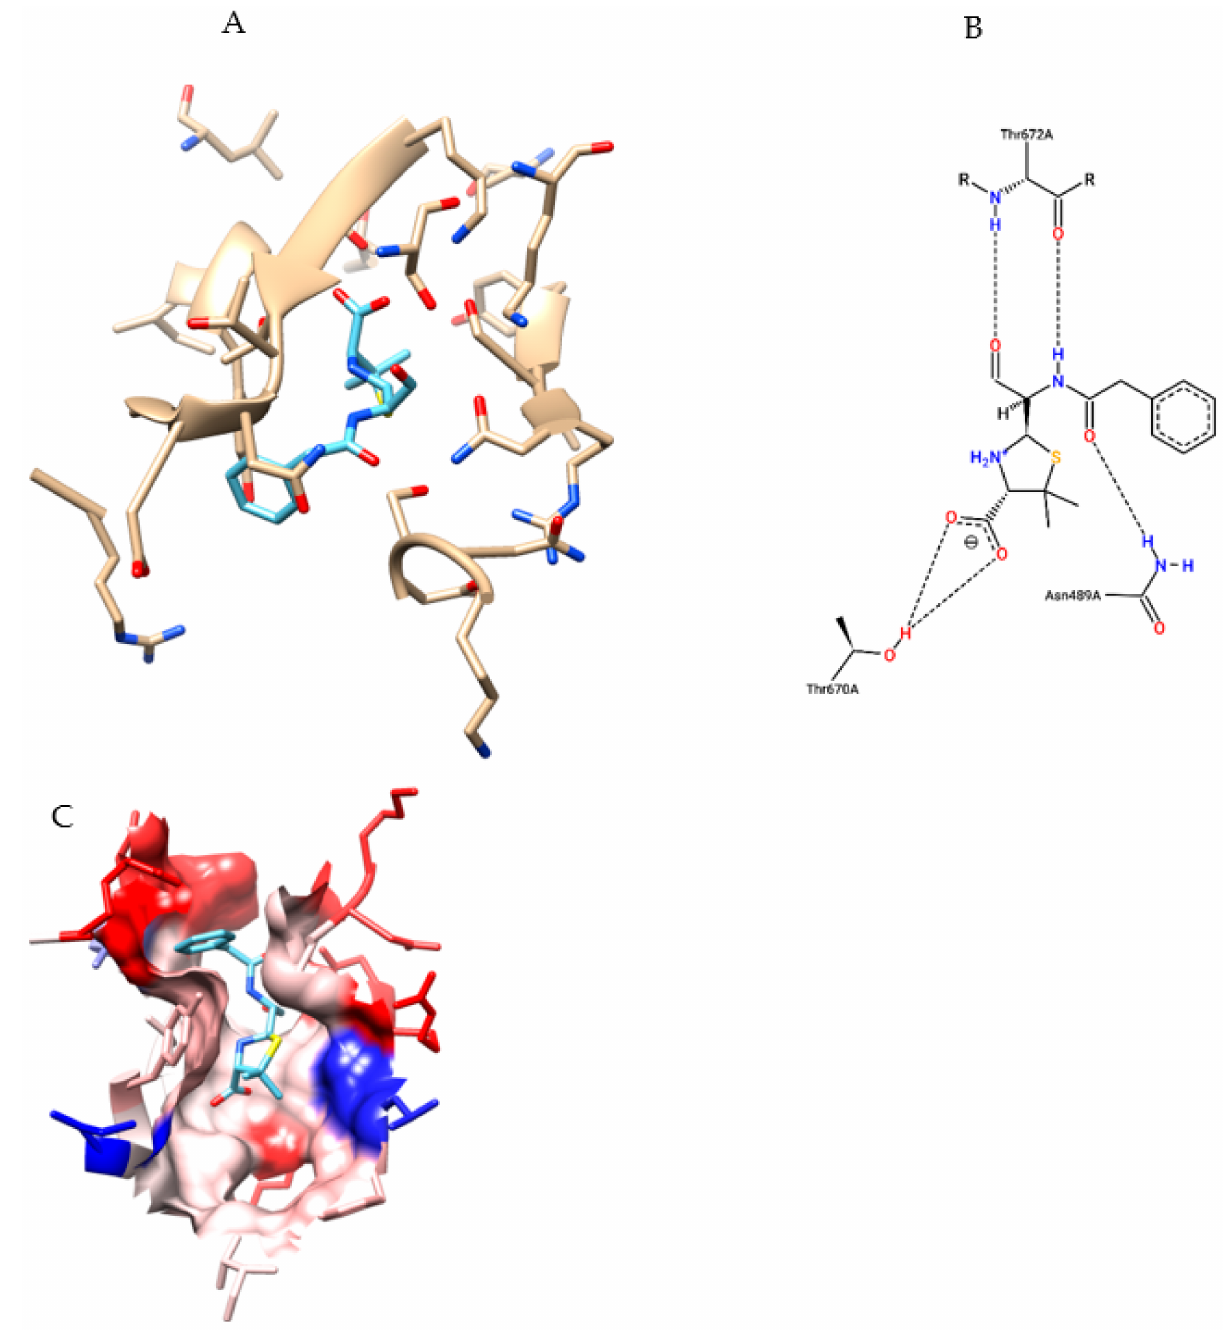
Figure 5. Reference ligand interaction with PBP protein, ( A ) 3D interaction, ( B ) hydrogen bond formation, ( C ) Hydrophobic interaction (represented by blue